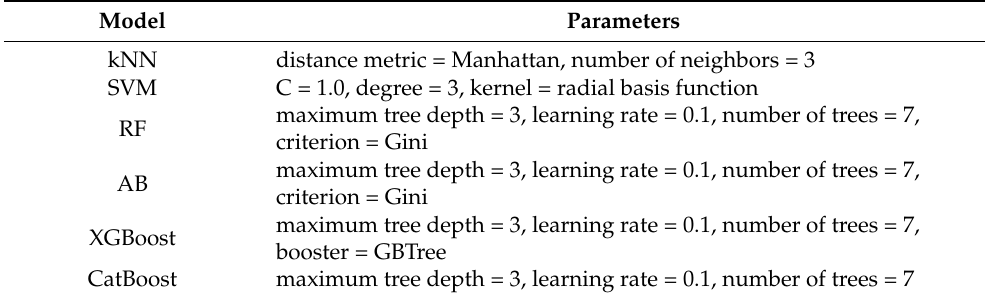
Table 2. Classifier_A hyperparameters.